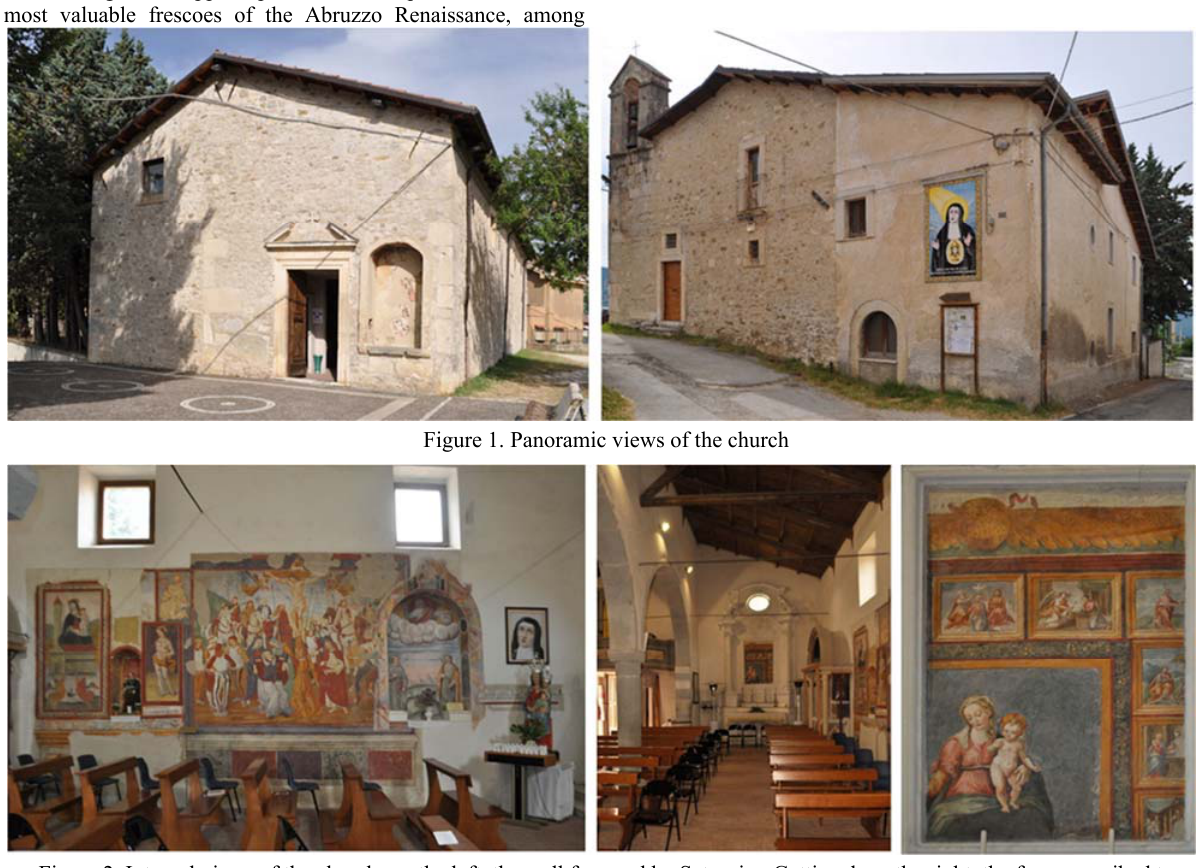
Figure 2. Internal views of the church: on the left, the wall frescoed by Saturnino Gatti and, on the right, the fresco ascribed to Pompeo